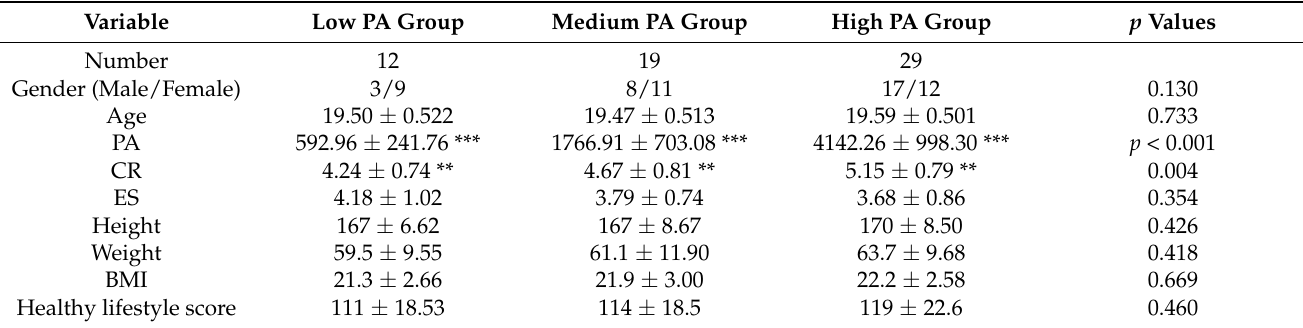
Table 1. Participant demographics, physical activity, and emotional regulation